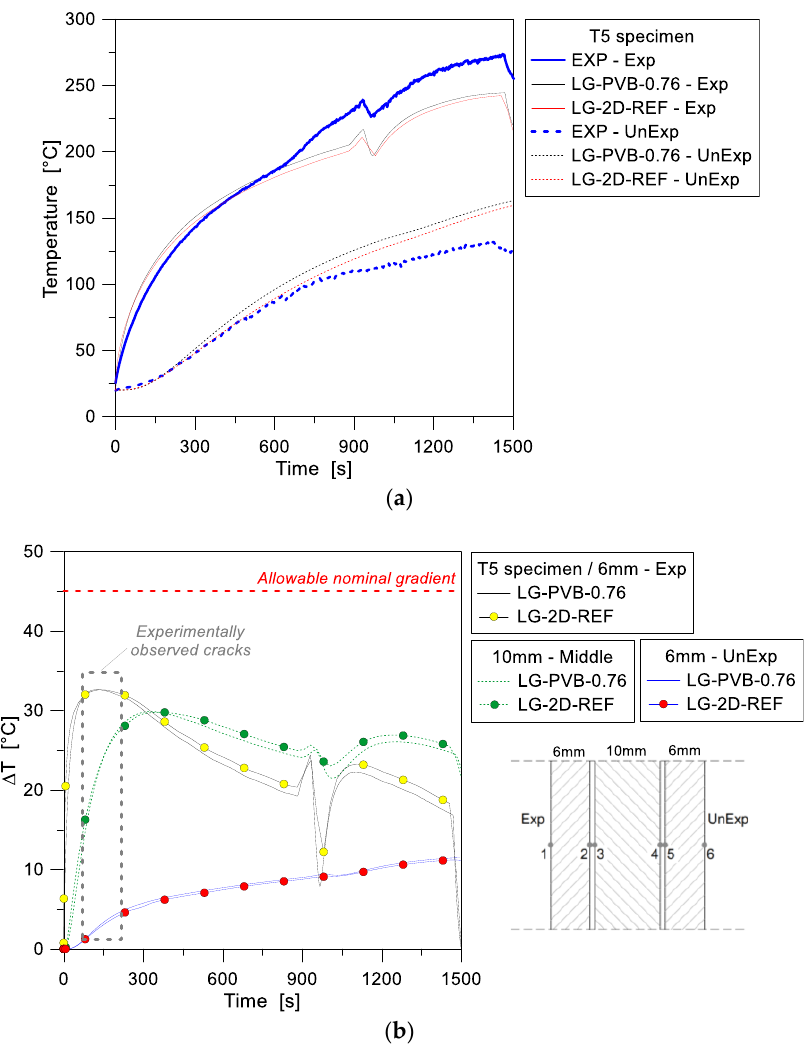
Figure 17. Comparative results for the LG sample T5, as obtained from the FE analyses (ABAQUS, 1D and 2D) and the past experimental test. ( a ) Temperature histories and ( b ) gradients.